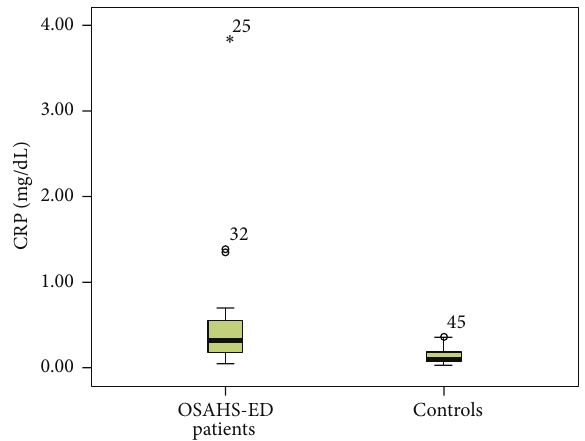
Figure 3: Interleukin-6 (IL-6) levels (pg/mL) are significantly higher in OSAHS patients with ED (OSAHS-ED) compared to controls ( 𝑃 < 0.001 ). IL-6 concentrations are shown as median (interquartile range) in the boxes.